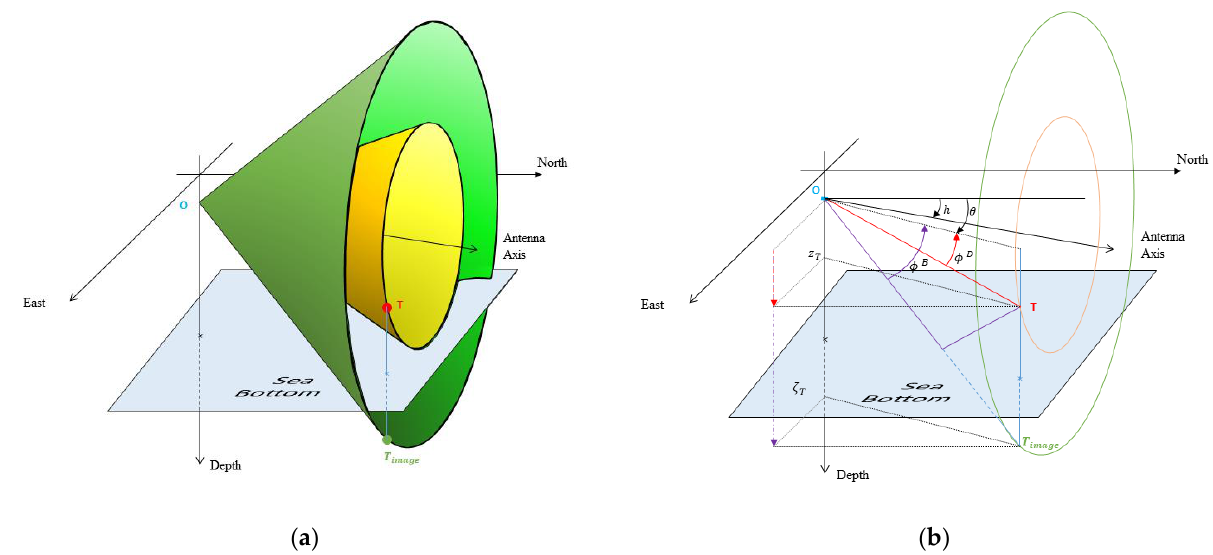
Figure 3. Cones of ambiguity. ( a ) The cones that the target belongs to, and the one that the image-target belongs to. ( b ) Example of conical angles of the target and of the image-target, for a bottom-reflected ray: φ D and φ B are the elevations of the direct path and of the bottom-reflected path, respectively.